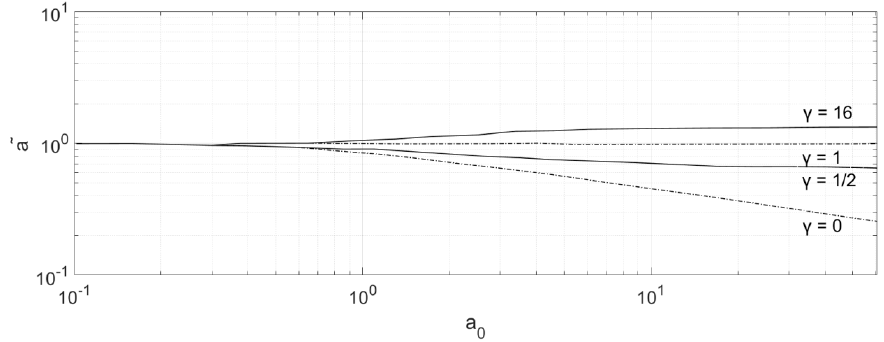
Figure 4. Pressure p(cid:3556) (cid:2868) as a function of a (cid:2868) ( δ = γ ) [26].